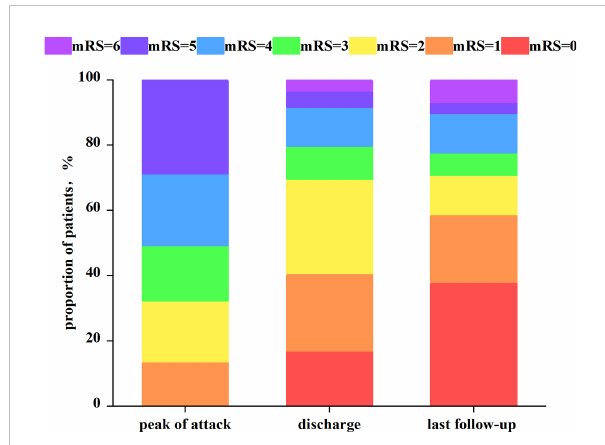
FIGURE 5 Distribution of the modi fi ed Rankin Scale score at the peak of the attack, discharge, and the last